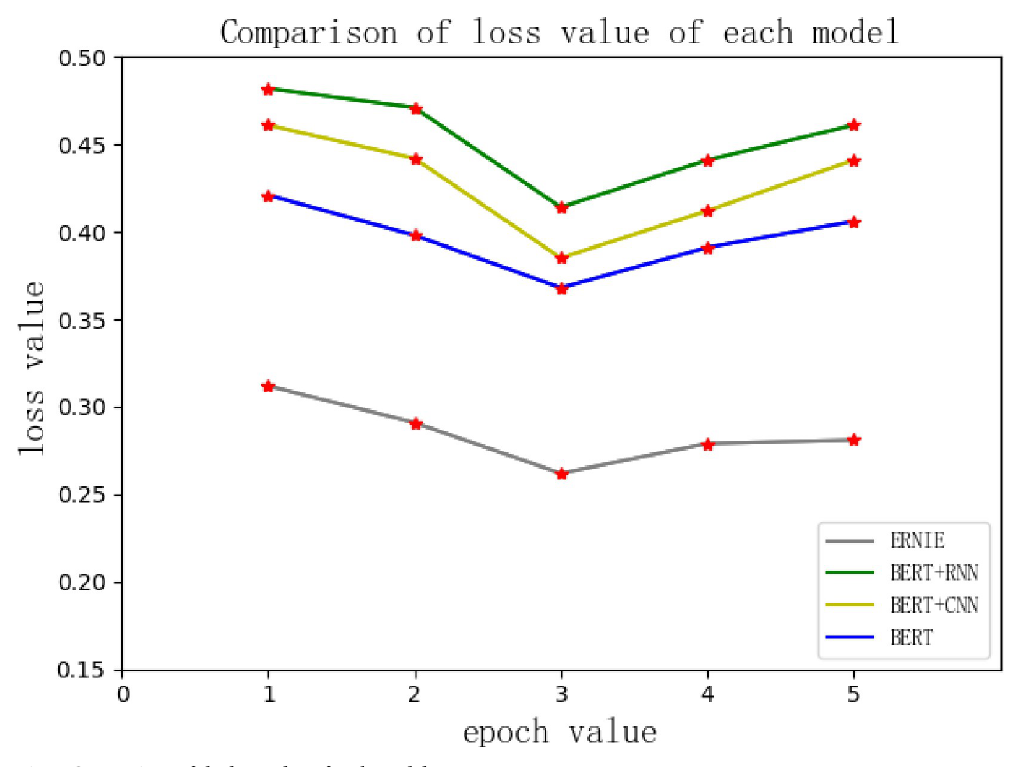
Fig 7. Comparison of the loss value of each